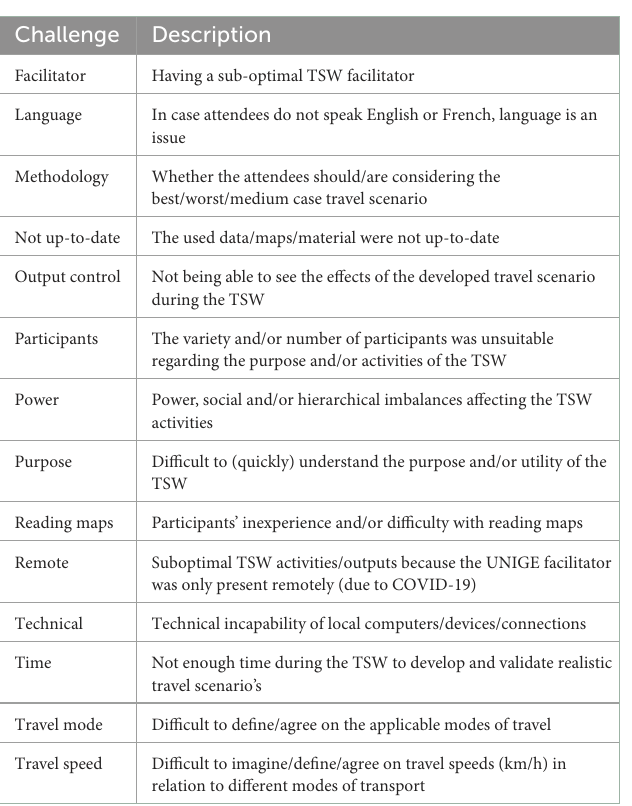
TABLE 2 Identified challenges.